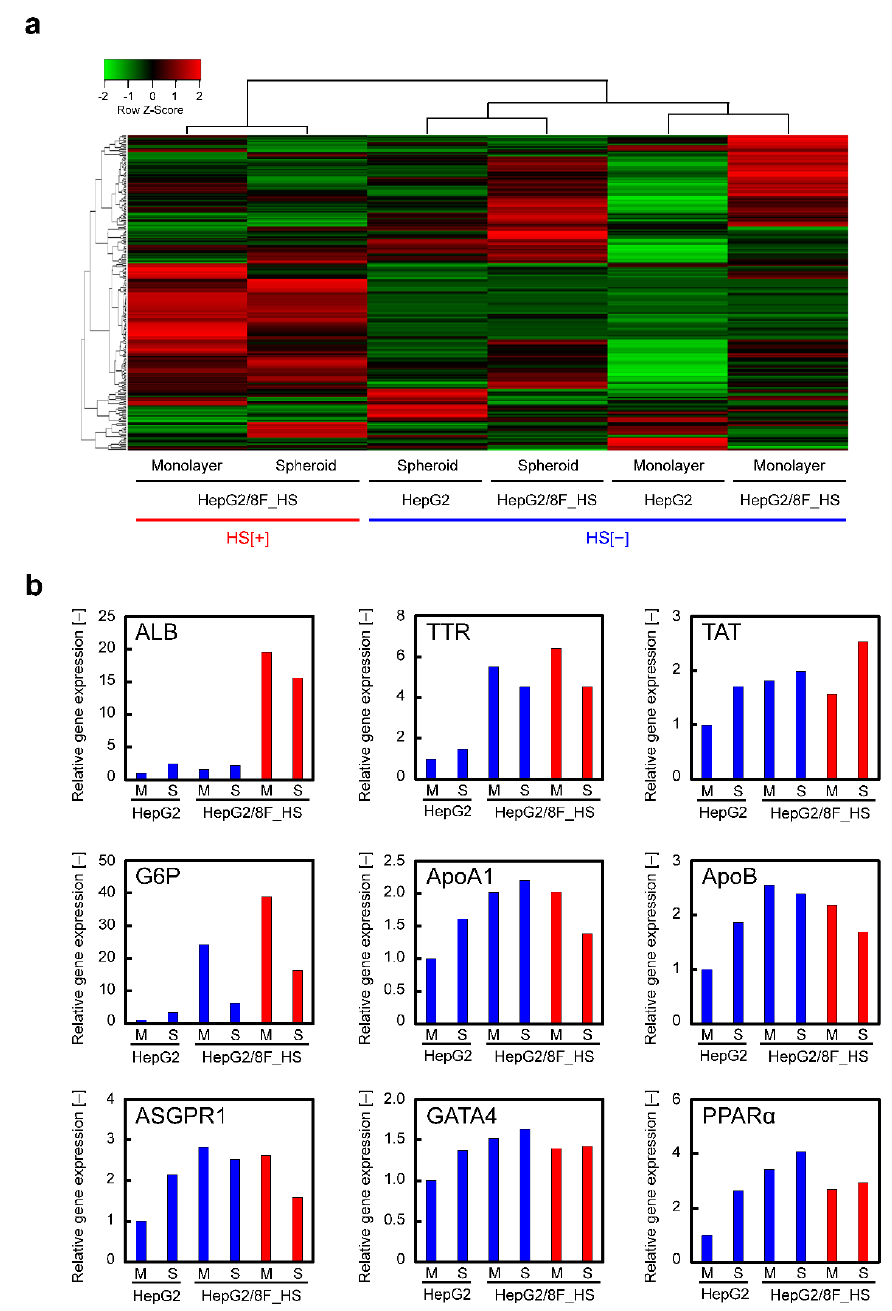
Figure 6. Analysis of the expression of liver-related genes in HepG2 and HepG2/8F_HS cells using DNA microarrays: ( a ) Heatmap analysis of liver-related gene expression in HepG2 and HepG2/8F_HS cells with (HS[+]) or without (HS[−]) heat treatment in monolayer and spheroid cultures. Hierarchical clustering was analyzed using the Pearson’s correlation distance/average linkage method. ( b ) Relative gene expression of liver-related genes. Cells were cultured with (red columns) or without (blue columns) heat treatment. M, monolayer; S, spheroid.